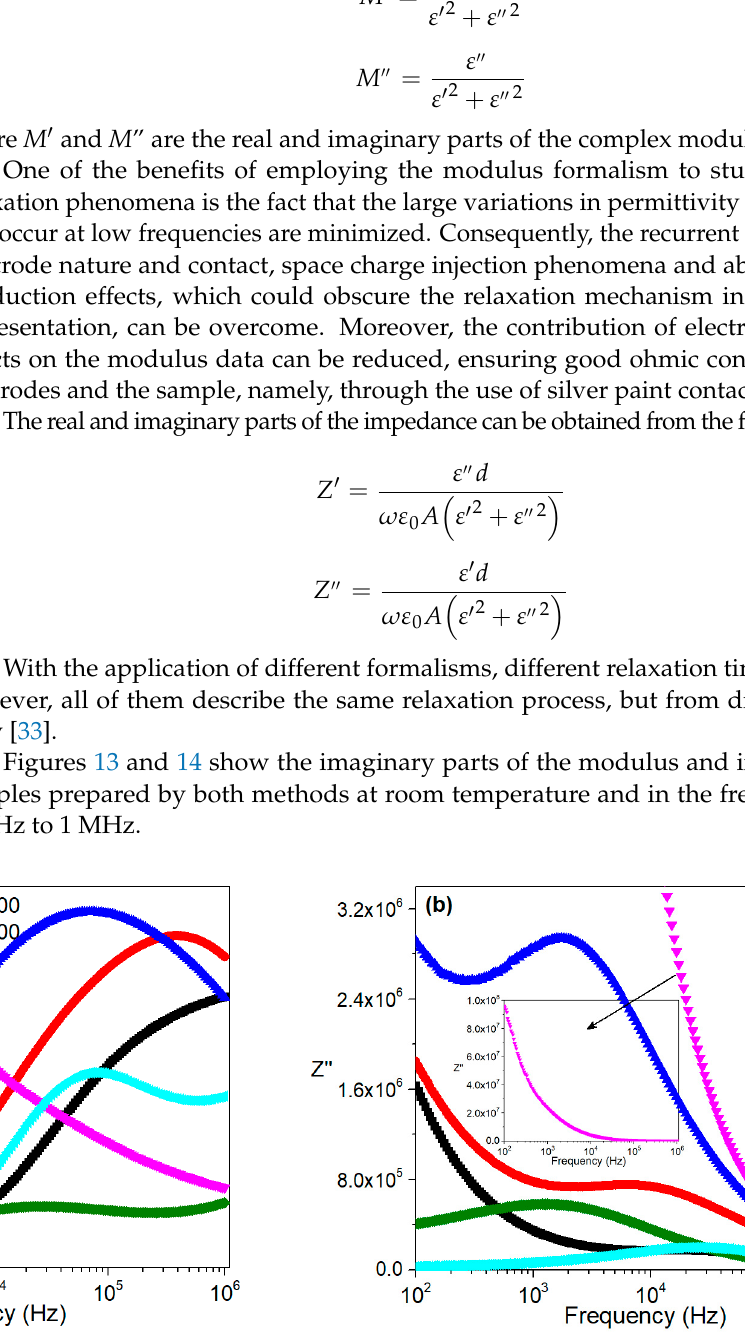
Figure 13. Frequency dependence of the imaginary parts of the ( a ) modulus and ( b ) impedance at room temperature for the samples prepared via the colloidal gel method.